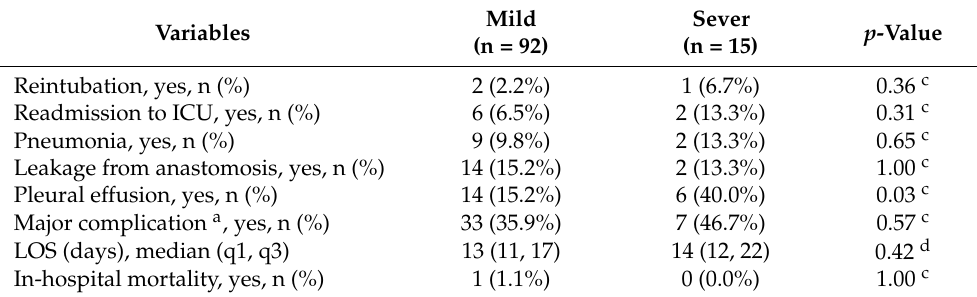
Table 3. Surgical outcomes of the two groups.